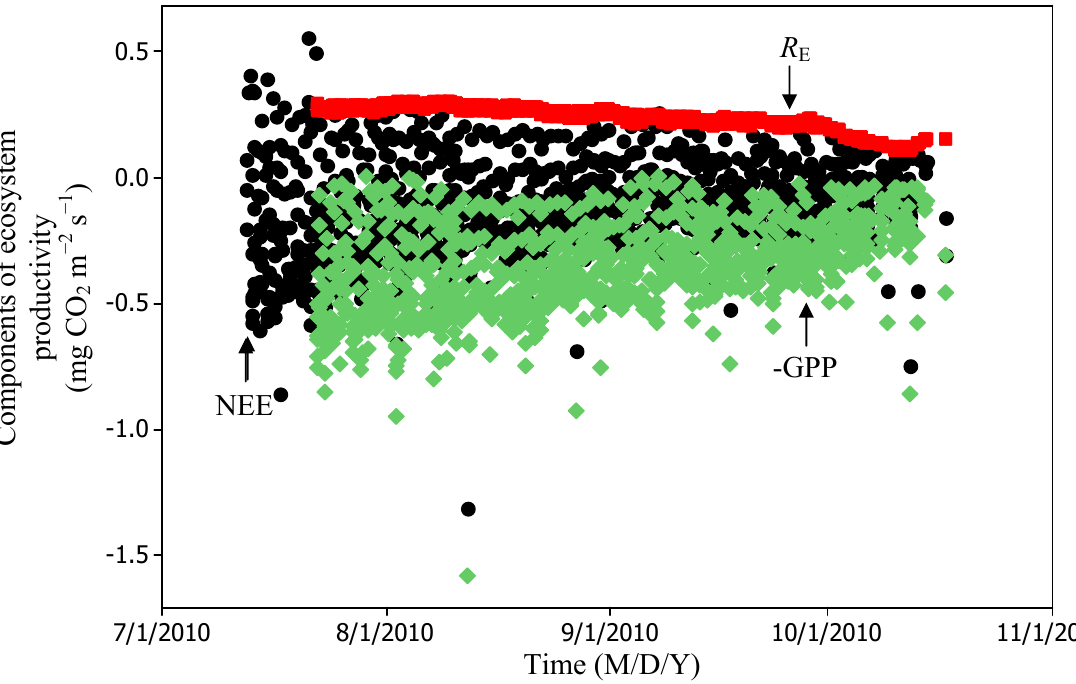
components for the Yenicaga peatland based E ). E